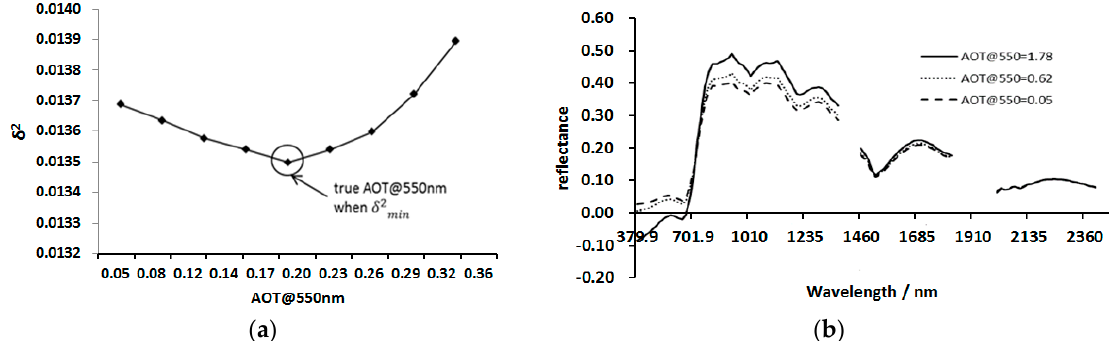
Figure 4. ( a ) Cost function δ 2 values of the aerosol optical thickness (AOT) retrieval. The best estimates of AOT occur at the minimum. ( b ) CASI and SASI reflectances over Dense Dark Vegetation (DDV) in the presence of different AOTs.